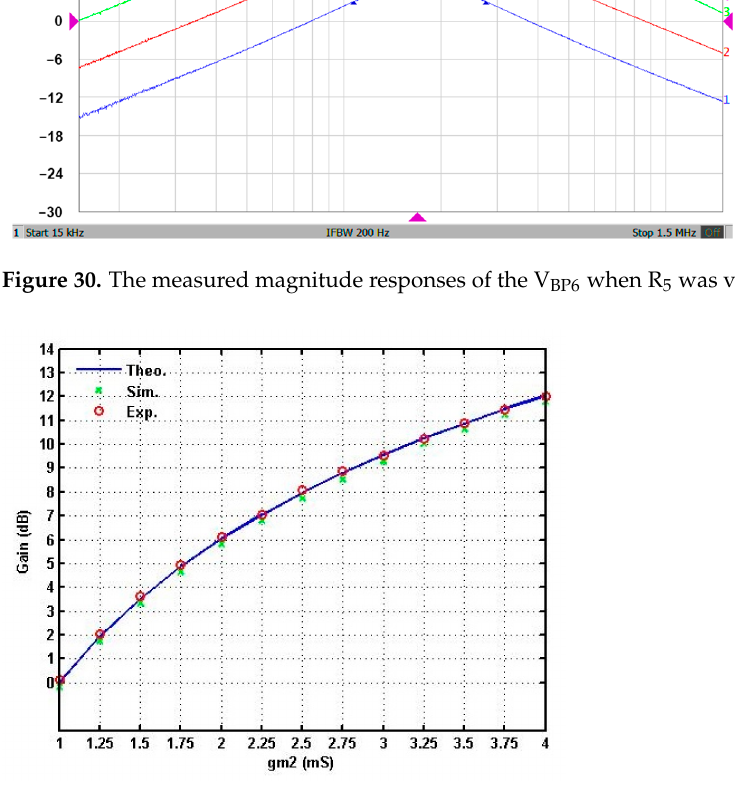
Figure 31. The theoretical, simulated and measured results of the electronic amplitude adjustable